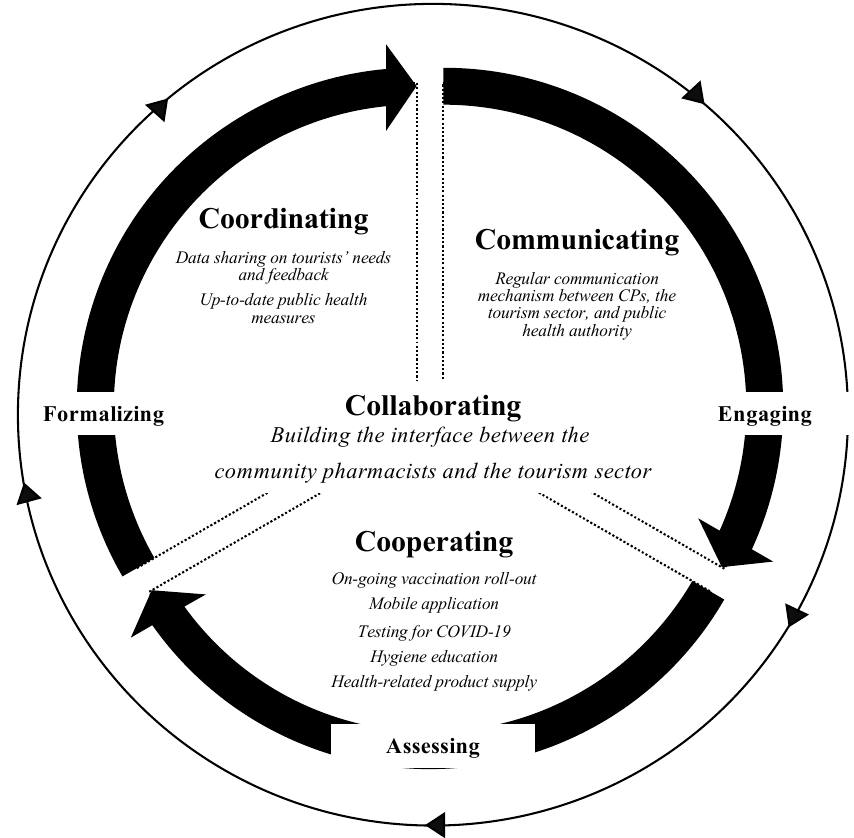
Figure 4. Emerging model of collaborative practices after responses from Macao’s CPs and tourism sector.